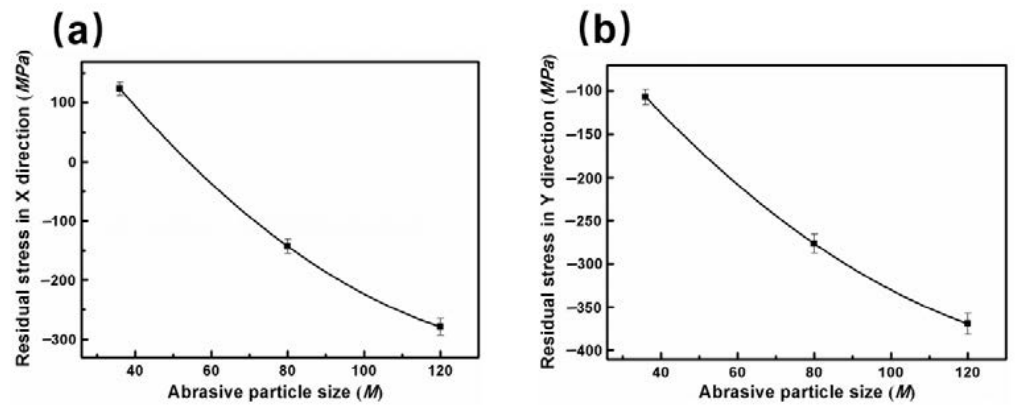
Figure 10. The relationship between surface residual stress and abrasive particle size: ( a ) X direction and ( b ) Y